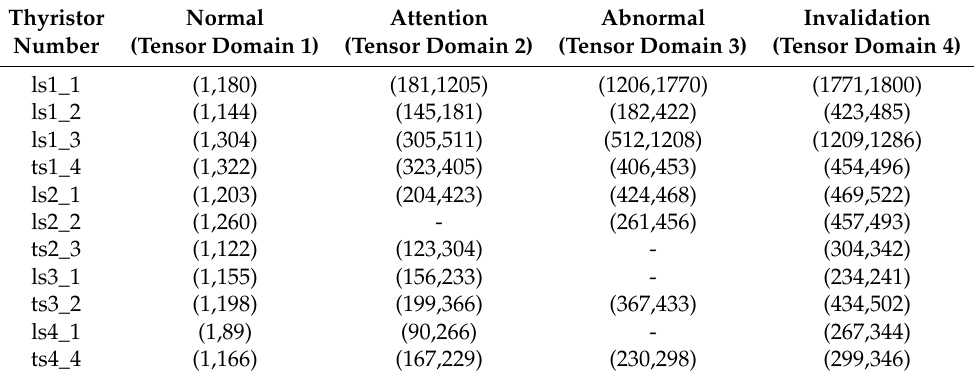
Table 2. Results of data